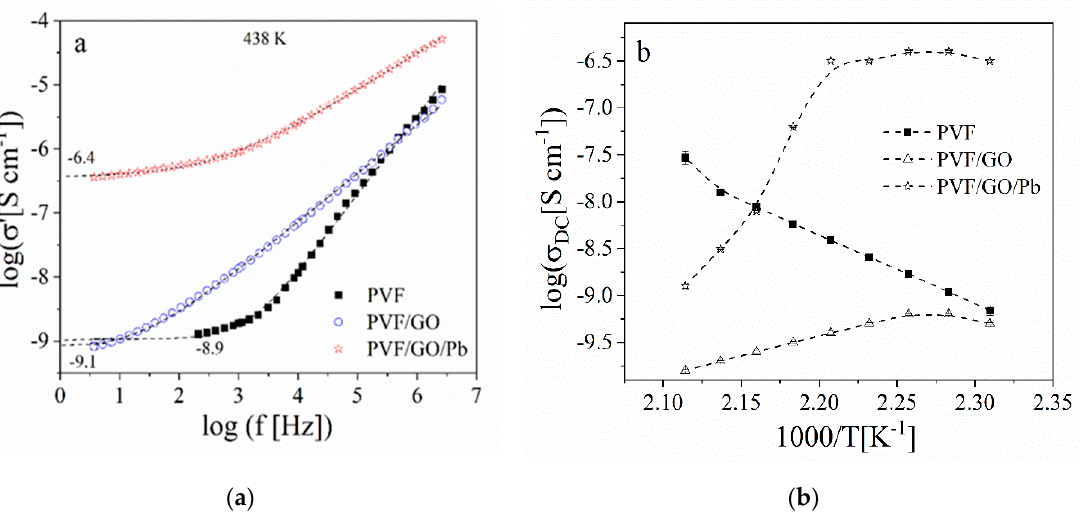
Figure 9. The real part σ ’ of the complex conductivity versus the frequency at 438 K for PVF/GO and PVF/GO/Pb composite in comparison to pure PVF ( a ), with DC conductivity σ DC for PVF/GO and PVF/GO/Pb composite in comparison to pure PVF versus inverse temperature ( b ).